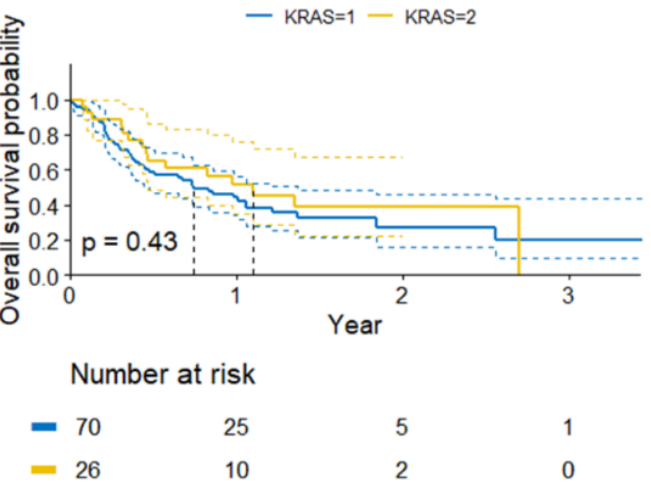
Figure 5. Probability of survival in subgroups by KRAS mutation status.